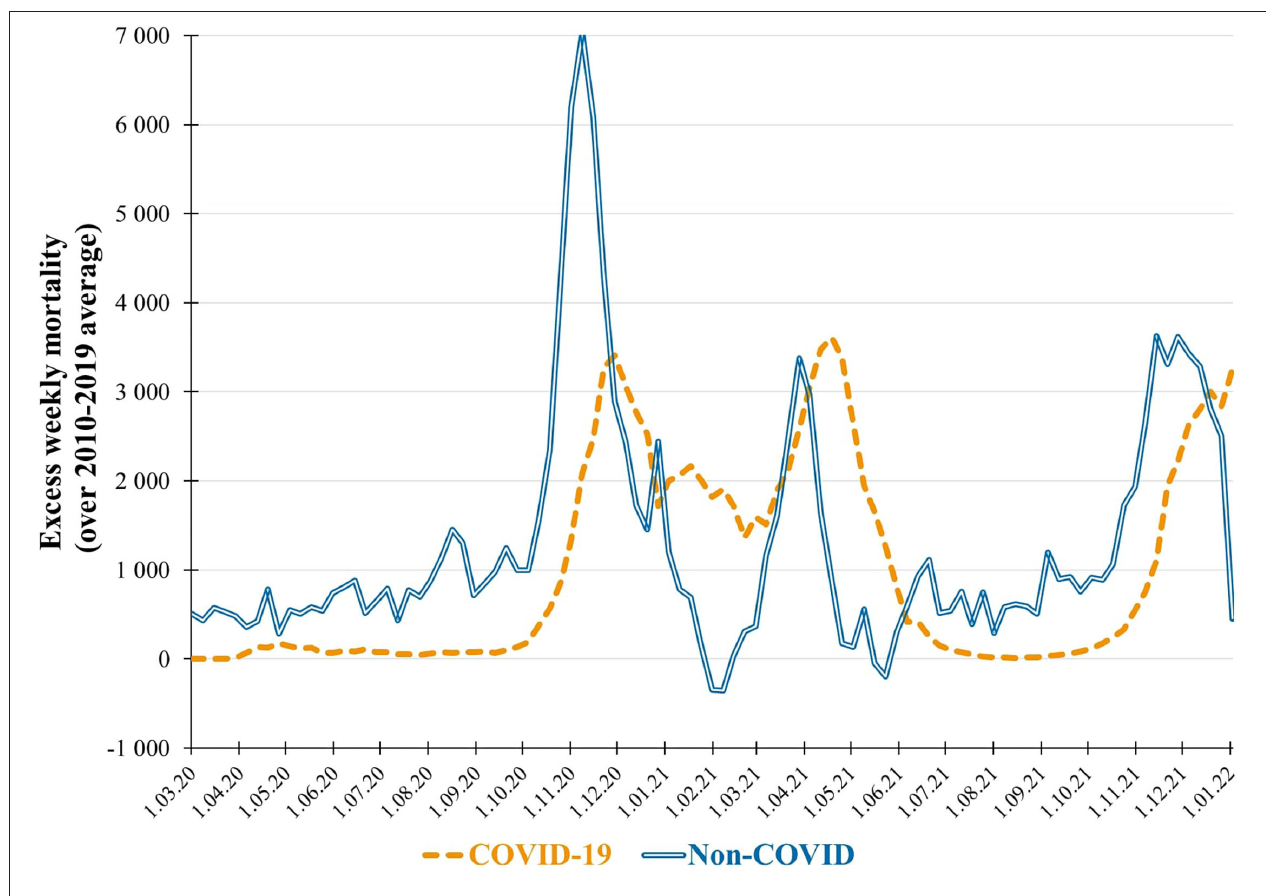
FIGURE 1 | Weekly excess mortality over 2010 − 2019